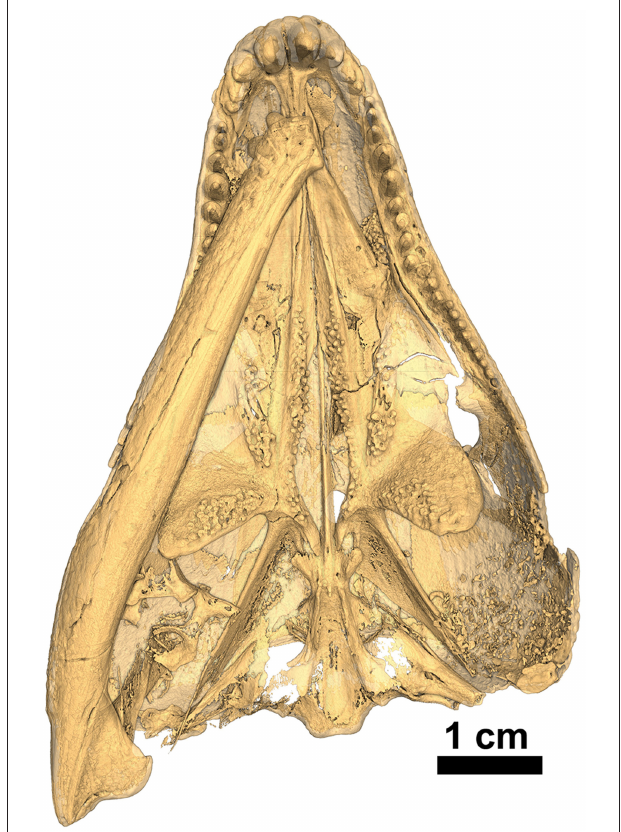
FIGURE 10 | Isomorphic rendering of a neutron scan of the holotype of Captorhinus kierani in palatal view. Note the presence of a pair of teeth on the parasphenoid (derived condition) and the multiple rows of teeth along the medial margin of the anterior process of the pterygoid (primitive condition).